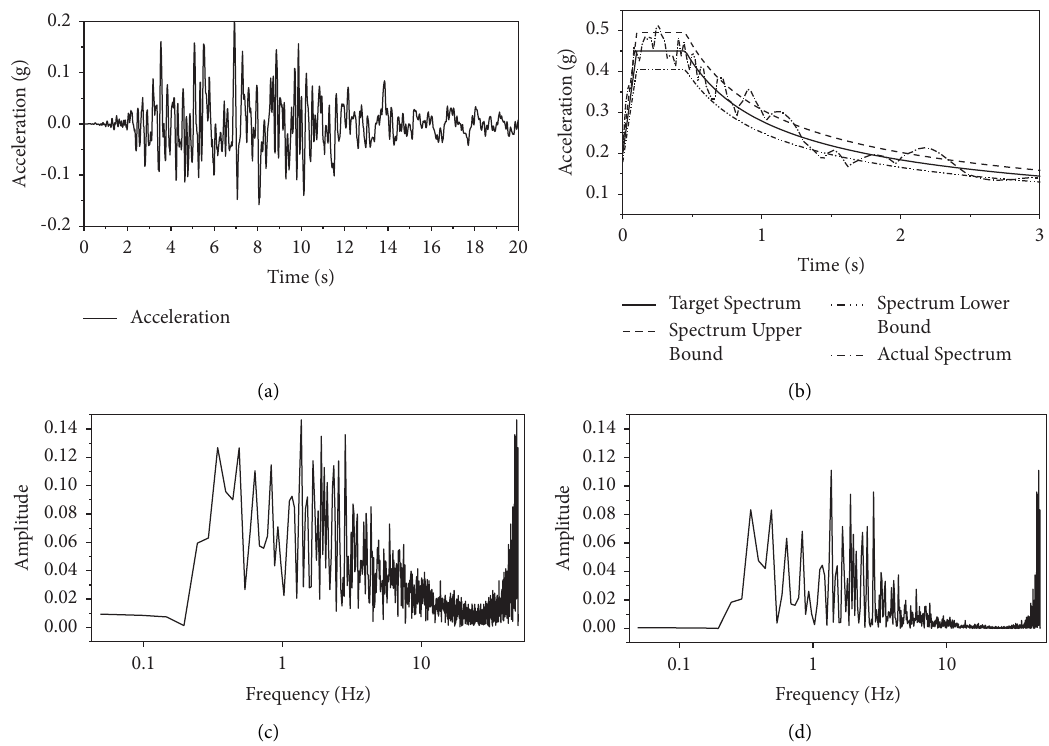
Figure 7: Acceleration time history curve of the artifcially adjusted peak value of Kobe seismic wave. (a) Acceleration time history curve of Kobe wave. (b) Comparison of Kobe wave response spectrum and design reaction spectrum. (c) Kobe wave Fourier spectrum. (d) Kobe wave power